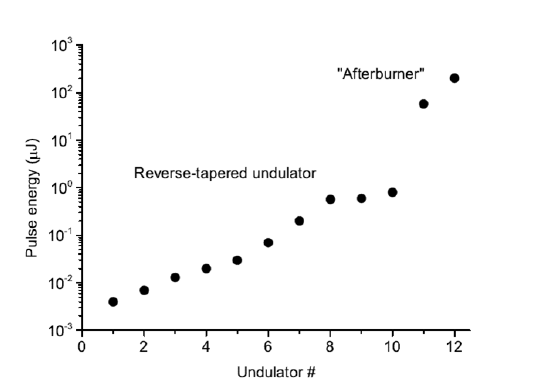
Figure 11. Radiation spectra generated in a frequency doubler experiment at FLASH2 tuned to equal pulse energies for the two wavelength taken with a grating spectrometer [14] in the experimental hall. In blue, the spectral line for the second harmonic at 4.5 nm, and in red, the first harmonic at 9 nm are shown. The electron beam energy in this experiment was 1080 MeV and the bunch charge 300 pC.